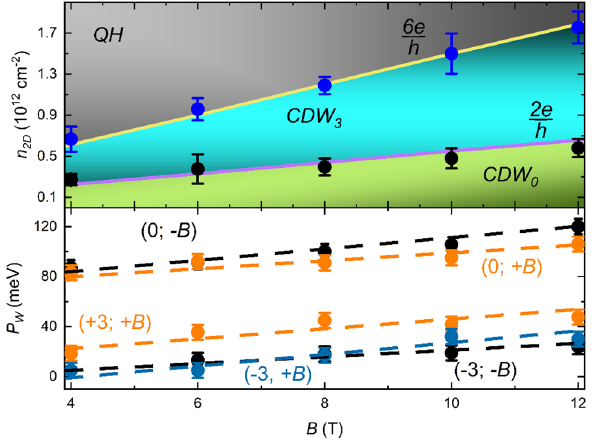
Figure 4. Magnetic field dependencies of plateau transition points and widths: top: Charge carrier densities 2 e 2 n 2 D at which a transition from 0 3 e h to 3 → 6 h are found (cf. Supplementary Note 4). Equivalent transition → points at positive and negative conductivity and both magnetic field directions were averaged. The resulting standard deviation, the relevant error here, is reflected in the displayed error bars. Solid lines have the theoretical slope 2 e h and 6 e h corresponding to the increasing LLs degeneracy with B . Remarkably, the experimentally observed transition points from CDW 0 to CDW 3 and CDW 3 to QH are in excellent agreement with both degeneracy lines. The indices denominate the transverse conductivity value, QH refers to the quantum Hall 3 e 2 0 and behavior. Bottom: Energy widths P w of the plateaus σ xy h found for S3 plotted as a function of ± = magnetic field strength (error bars account for the extended deflection at the plateau edges). The parentheses 2 ( ) . Dashed lines are denote the respective σ xy value in units of e h and the relative magnetic field direction ± guide to the